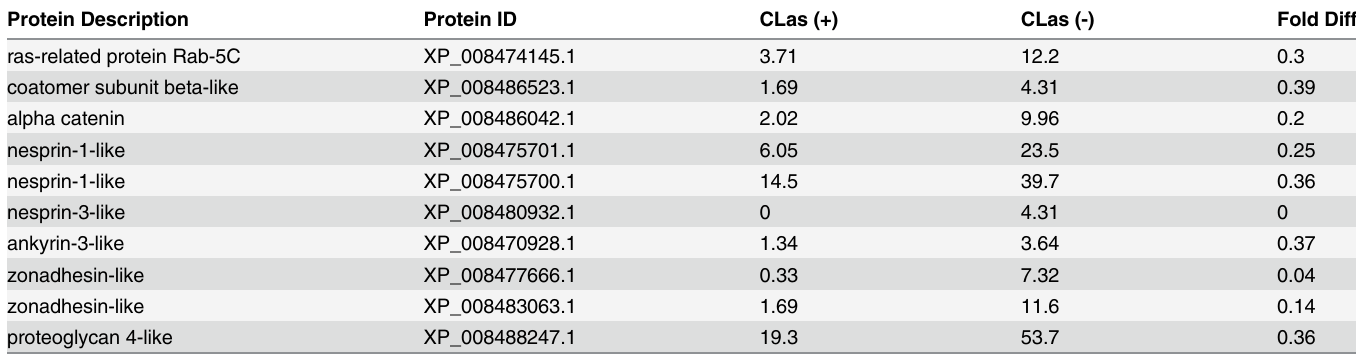
Table 5. Selected D . citri proteins associated with cell adhesion, endocytosis, and the cytoskeleton downregulated in CLas(+) insects. Average normalized peptide count from specified proteins and fold difference: CLas(+)/CLas(-). Protein